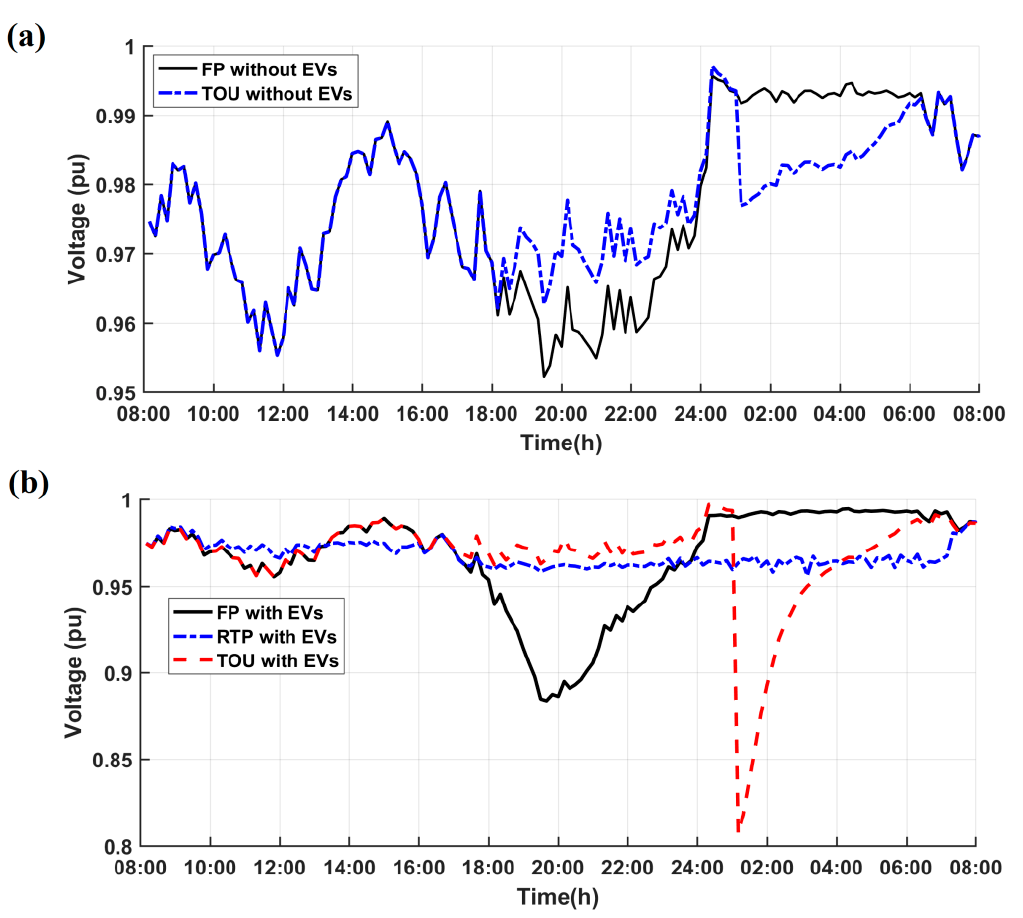
Figure 8. Voltage of the worse bus (#26) using FR, TOU and the proposed transactive method (RTP): ( a ) without EV; ( b ) With EVs.